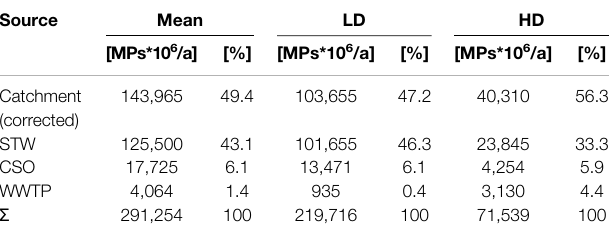
TABLE 4 | Annual microplastic (MP) emissions and percentage share of different sources and density classes. STW: stormwater, CSO: combined sewer over fl ows, WWTP: wastewater treatment plant, LD: low density MPs ( < 1.0 g/ cm 3 ), HD: high density MPs ( > 1 g/cm 3 ).